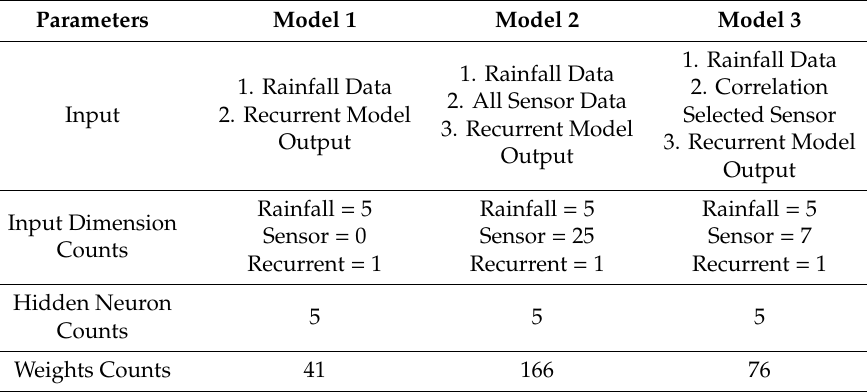
Table 2. Parameters of the proposed